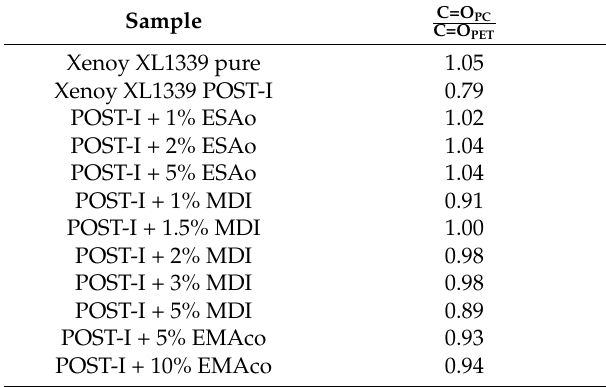
Table 3. Ratio between PC carbonyl stretching peak (C=O PC ) and that of PET (C=O PET ).